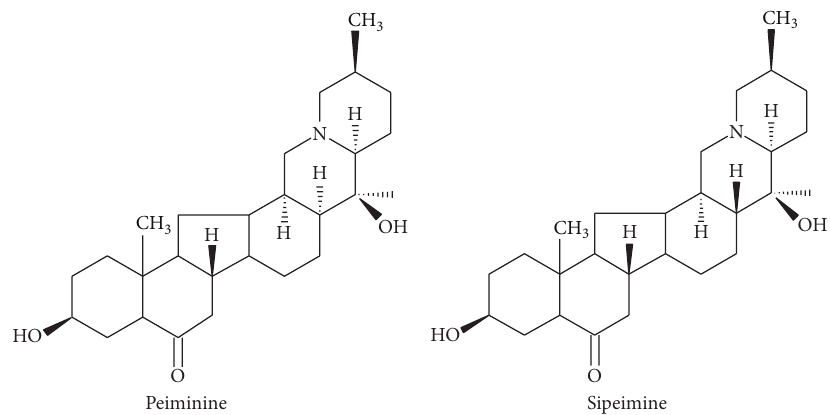
Figure 2: Structures of peiminine and